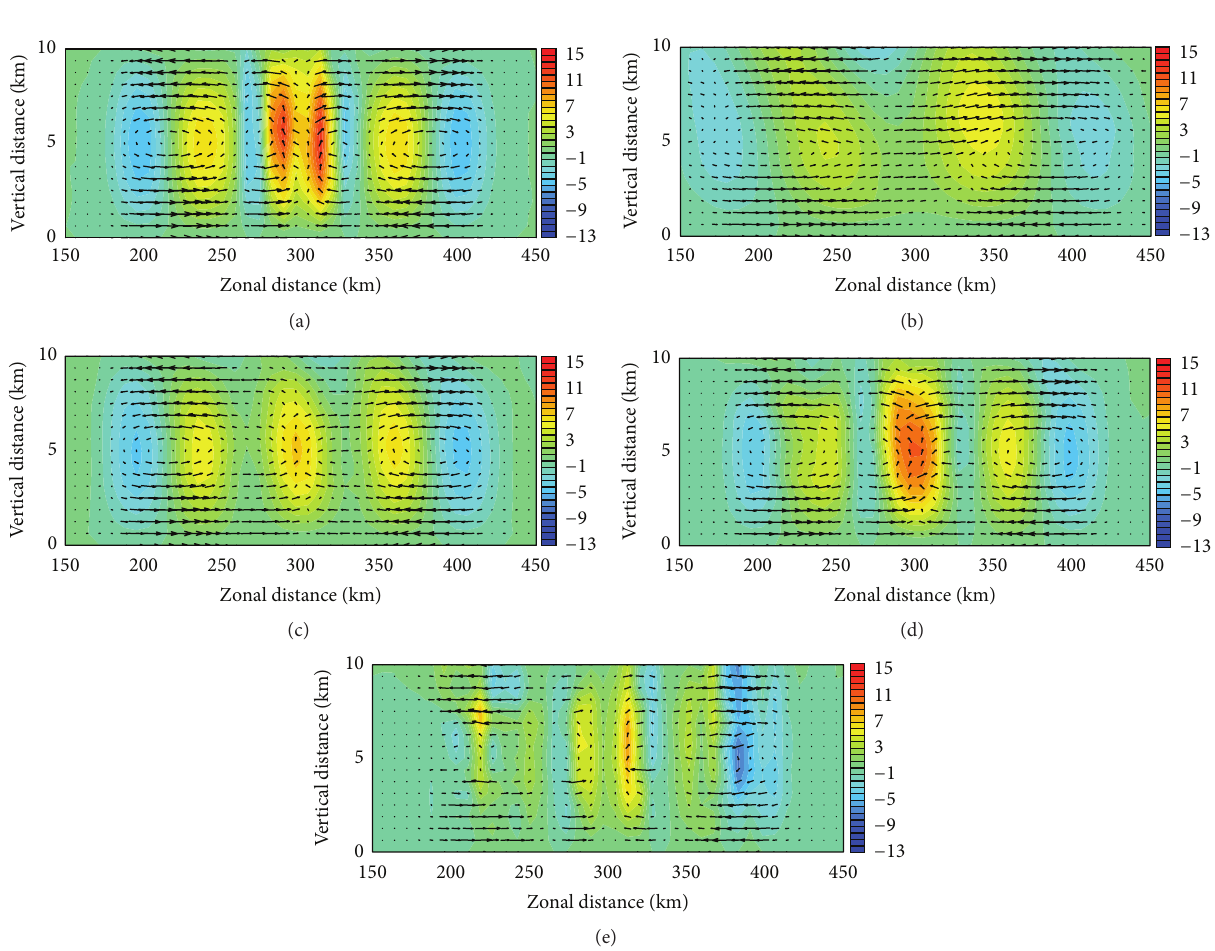
Figure 6: Vertical velocity section (color shade) and wind vector in this section across the typhoon center. (a) STMAS; (b) tradition 3D-Var with 𝐿 𝑥 = 50 km, 𝐿 𝑦 = 50 km, and 𝐿 𝑧 = 5 km; (c) tradition 3D-Var with 𝐿 𝑥 = 25 km, 𝐿 𝑦 = 25 km, and 𝐿 𝑧 = 2.5 km; (d) tradition 3D-Var with 𝐿 𝑥 = 12.5 km, 𝐿 𝑦 = 12.5 km, and 𝐿 𝑧 = 1.25 km; (e) tradition 3D-Var with 𝐿 𝑥 = 6.25 km, 𝐿 𝑦 = 6.25 km, and 𝐿 𝑧 = 0.625 km (unit: